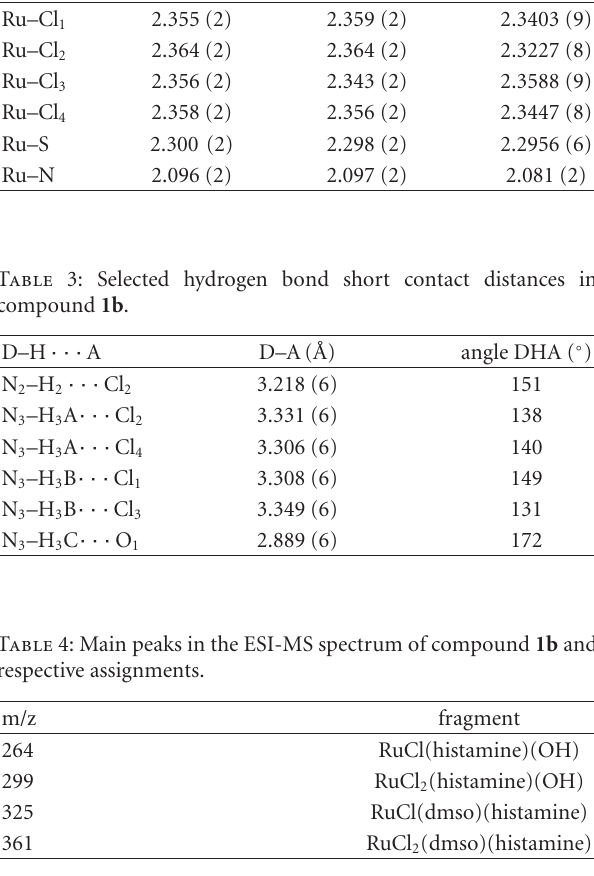
Table 2: Selected bond lengths in compounds 1a , 1b and NAMI